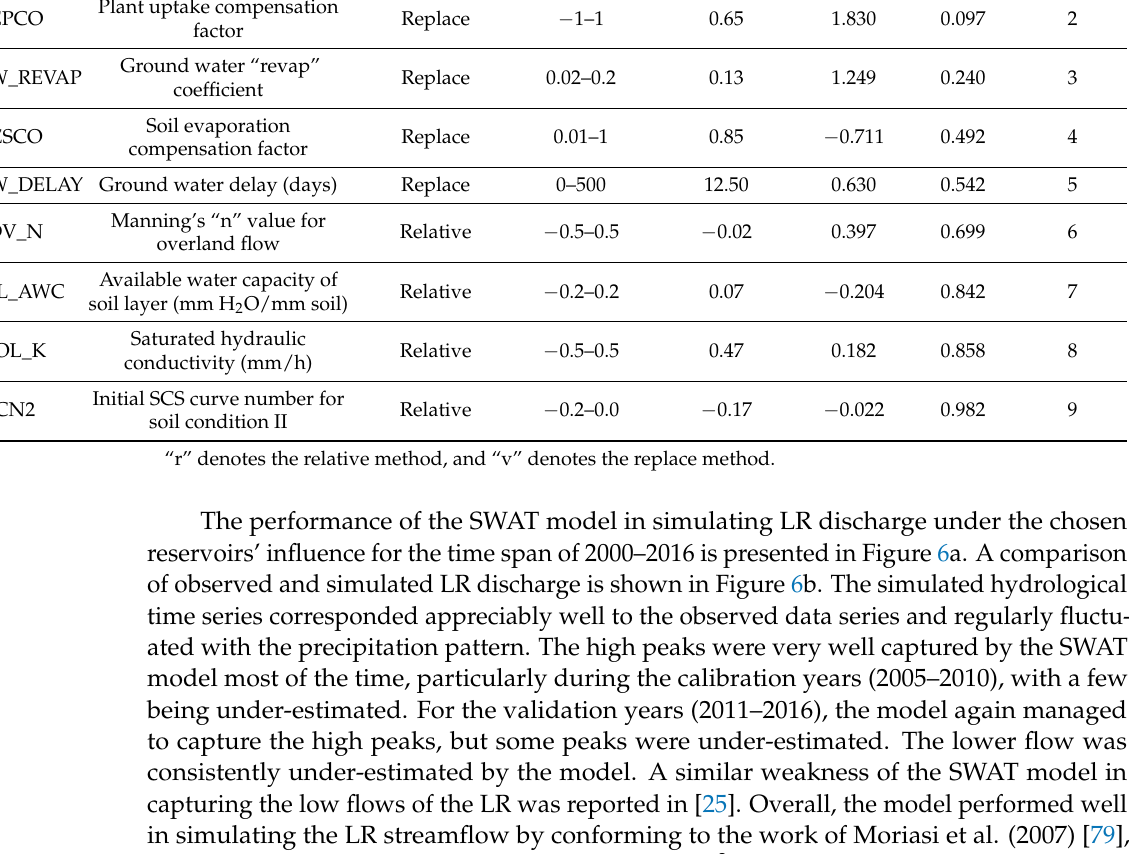
Table 3. Sensitivity of selected parameters in influencing Lhasa River flow.